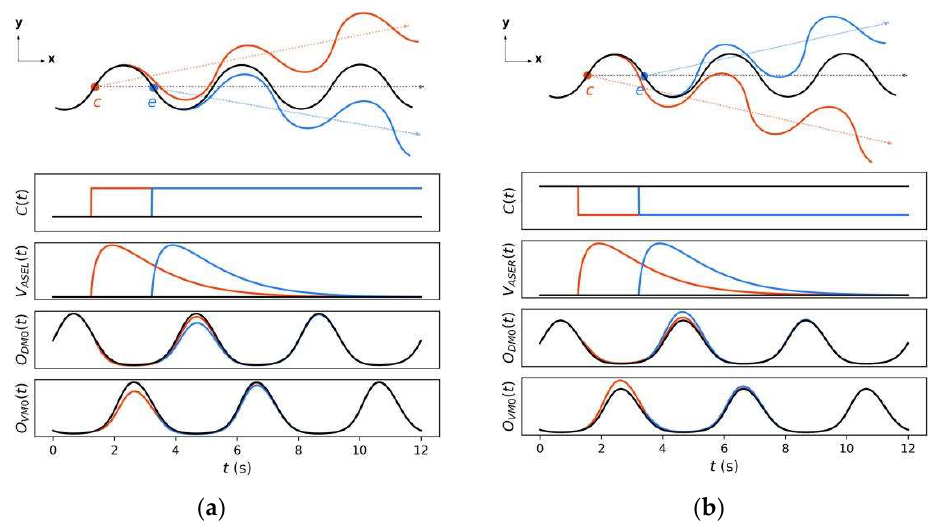
Figure 4. Changes in sensory neuron voltages and muscle outputs (bottom) as well as steering responses (top) caused by application of an up ( a ); or down ( b ) steps at two different locomotion phases. Black, orange, and blue represent the cases where no sensory stimulus is applied and where the sensory stimulus is applied at phase points c and e , respectively.